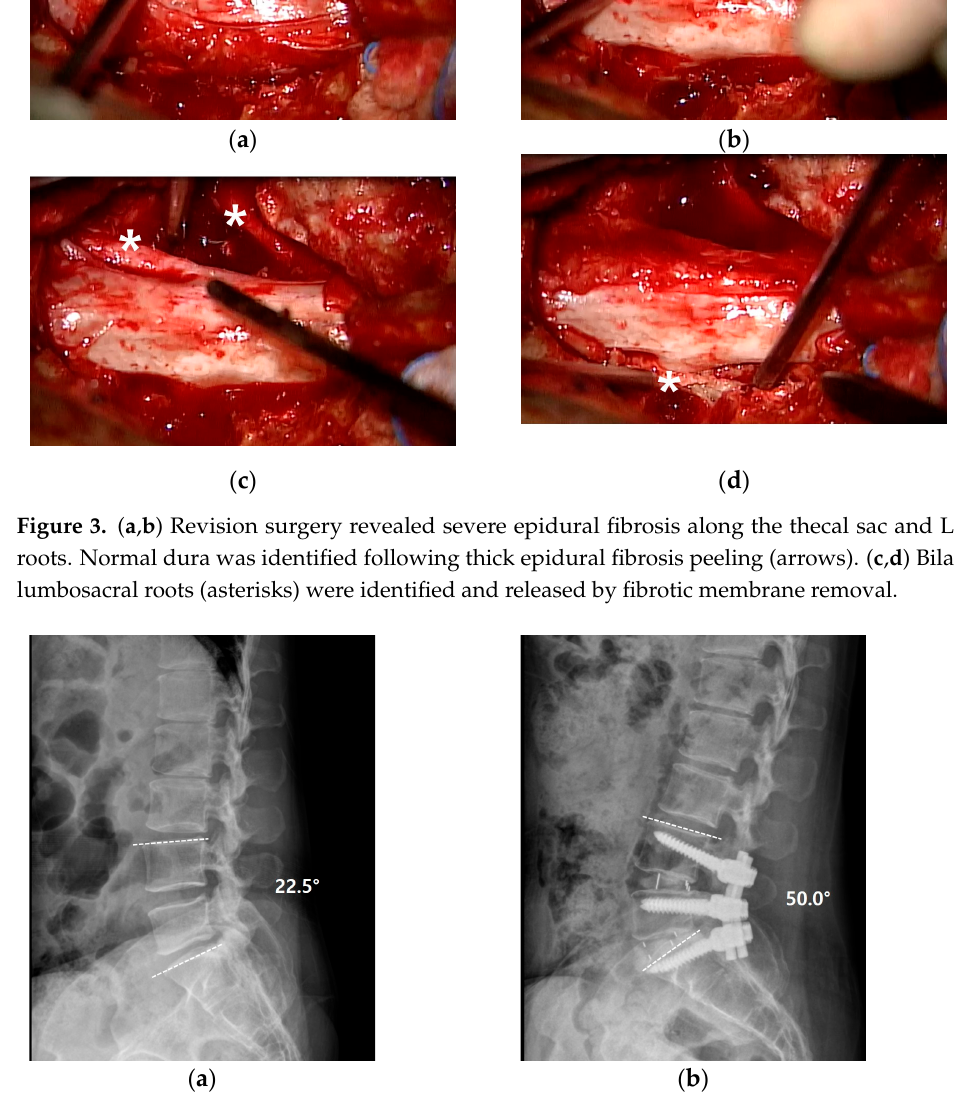
Figure 4. ( a , b ) Lordotic fusion from L4 to S1 with posterior column shortening was conducted to reduce neural tension and stretching of the nerve roots. Lower lumbar lordosis (L4–S1) was increased from 22.5° to 50.0° after surgery.